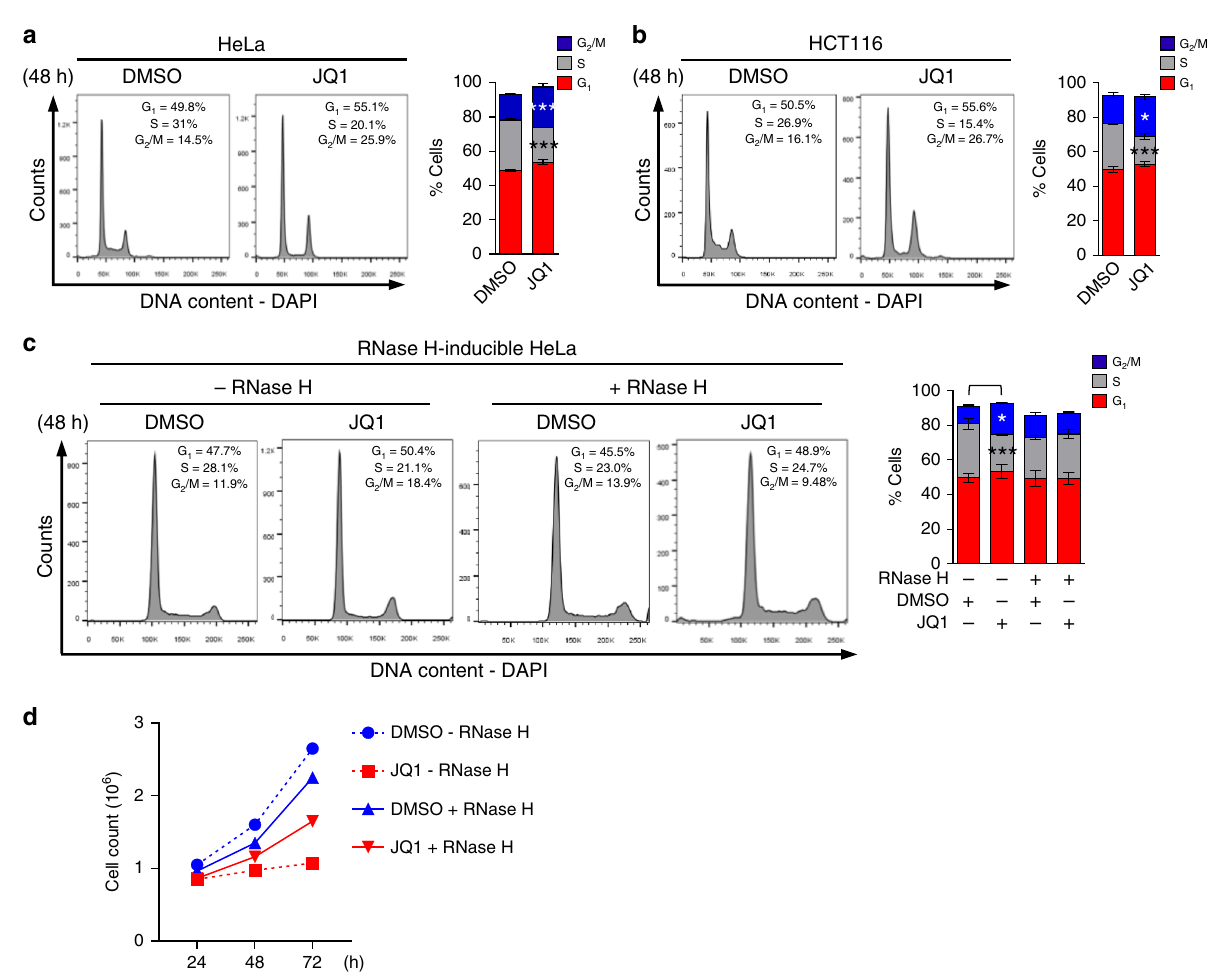
Fig. 9 BRD4 inhibition leads to changes in the percentages of S and G2/M phase cells. Representative images and quanti fi cation of fl ow cytometry cell cycle plots in a HeLa, b HCT116, and c RNase H-inducible HeLa cells following 48 h of JQ1 treatment. Data presented as mean ± SEM ( n = 3 separate experiments). Signi fi cance assessed using ANOVA followed by Sidak ’ s test in a (%S DMSO vs JQ1 ***Adjusted P = 0.0002; % G2/M DMSO vs JQ1 ***Adjusted P = 0.0004); b (%S